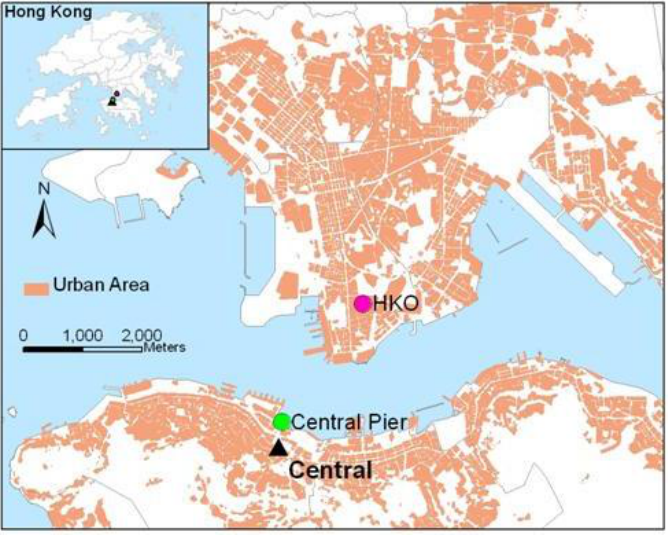
Central station, Central Pier and Hong Kong 2.5